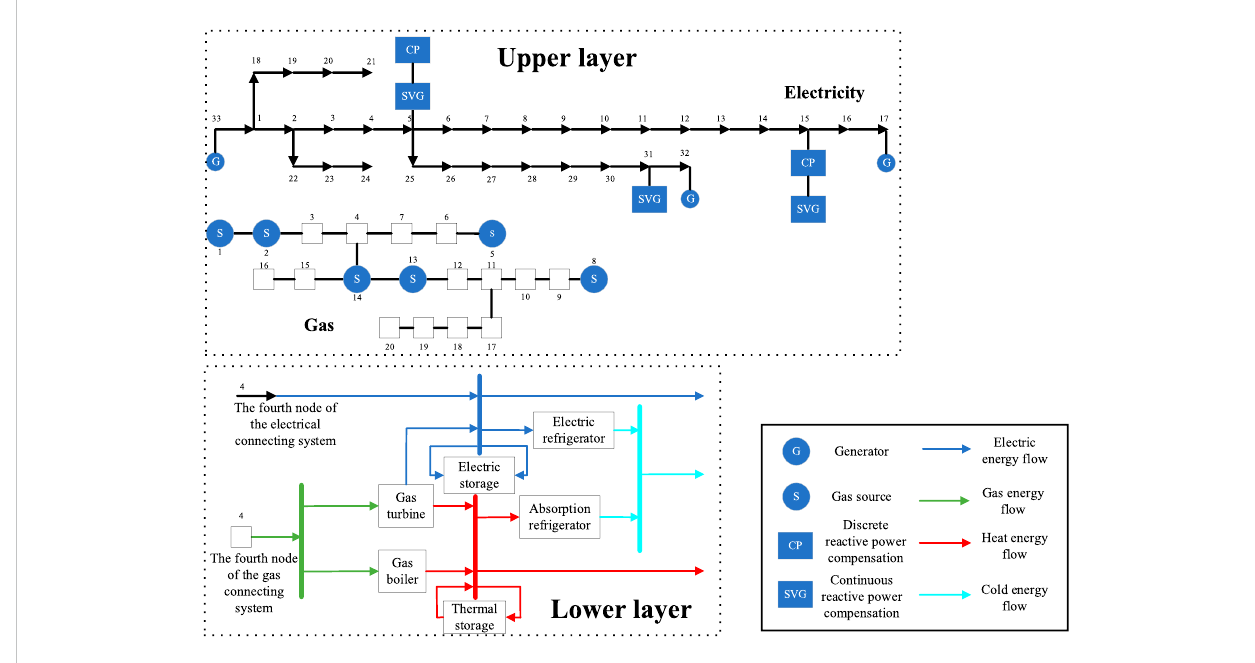
FIGURE 2 Model of the system used for simulation.